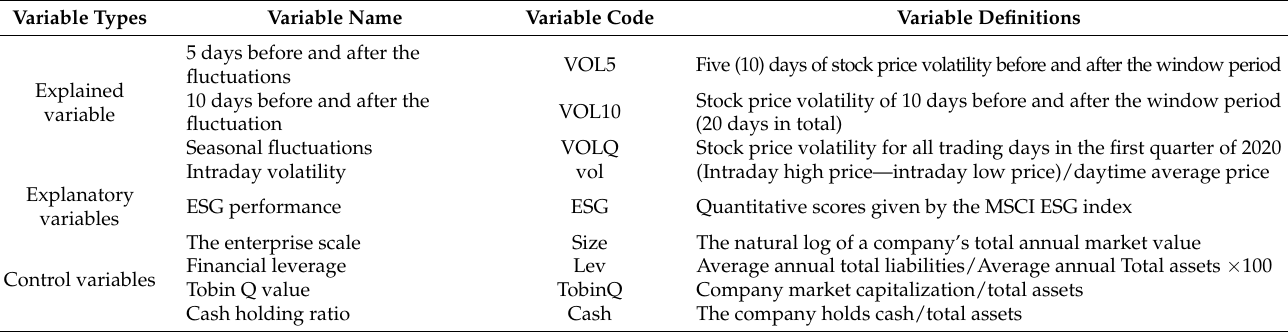
Table 1. Variable selection and